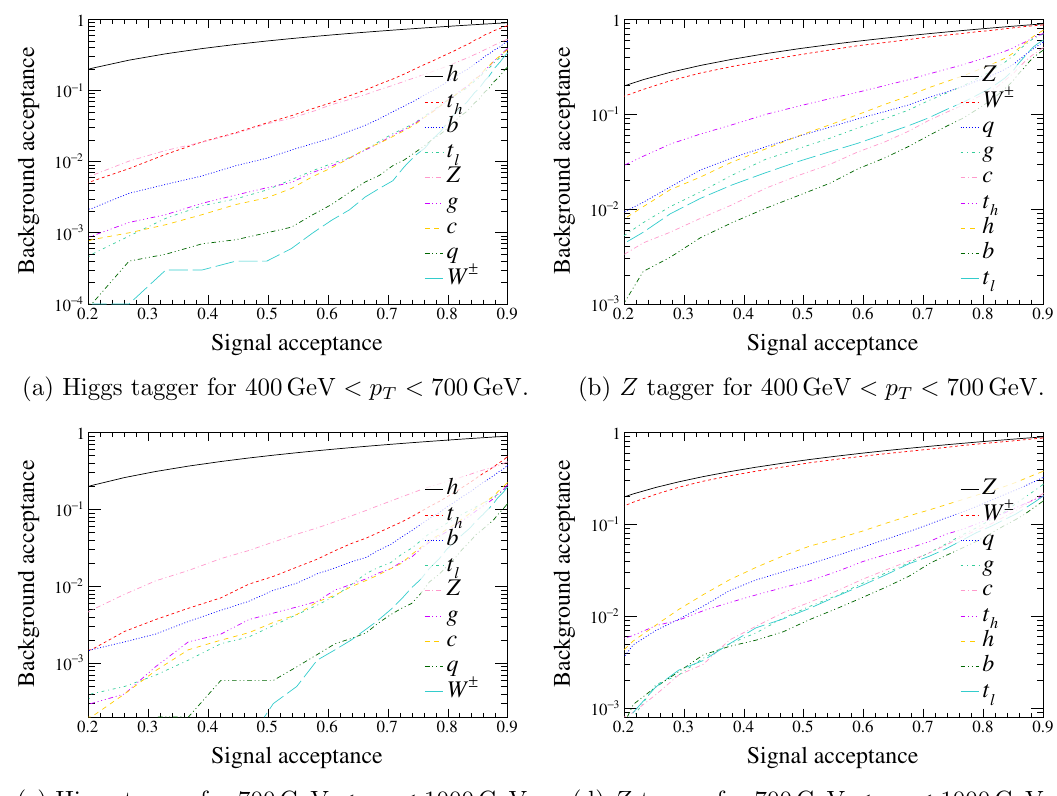
Figure 2. ROC curves of the signal and background acceptance for the Higgs tagger in a and c as well as for the Z -boson tagger in b and d. All processes are generated at 100 TeV via pair-production. (We are using an e(cid:11)ective model in order to produce Higgs boson pairs.) During production and tagging we have ensured that the transverse momenta are constrained to 400{700 GeV for a and b and to 700{1000 GeV for c and d. As the jet cone size is (cid:1) R = 0 : 5, we expect the bosons of